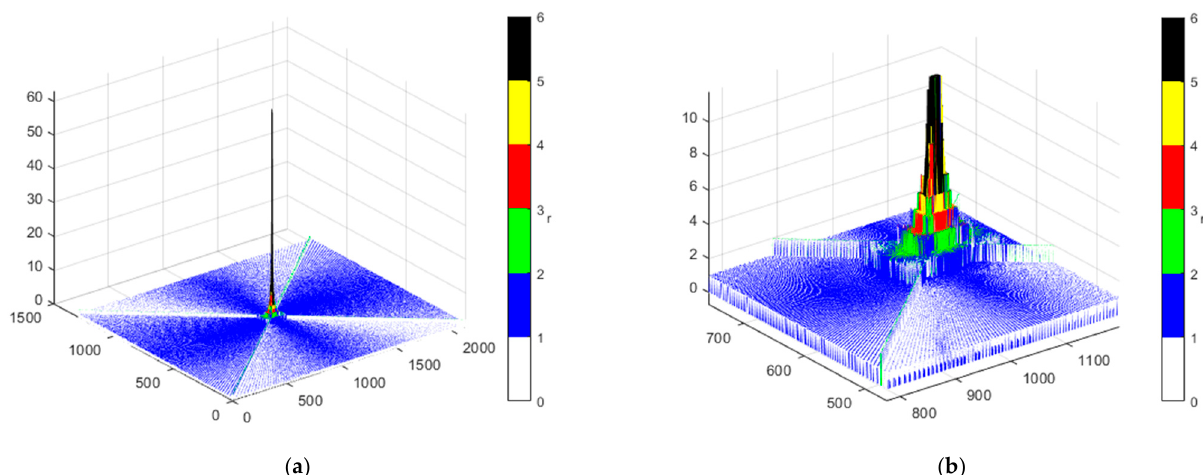
Figure 8. Redundancy r for points on sparse PAM matrix illustrated for ( a ) whole map area and ( b ) area with highest number of calculations.